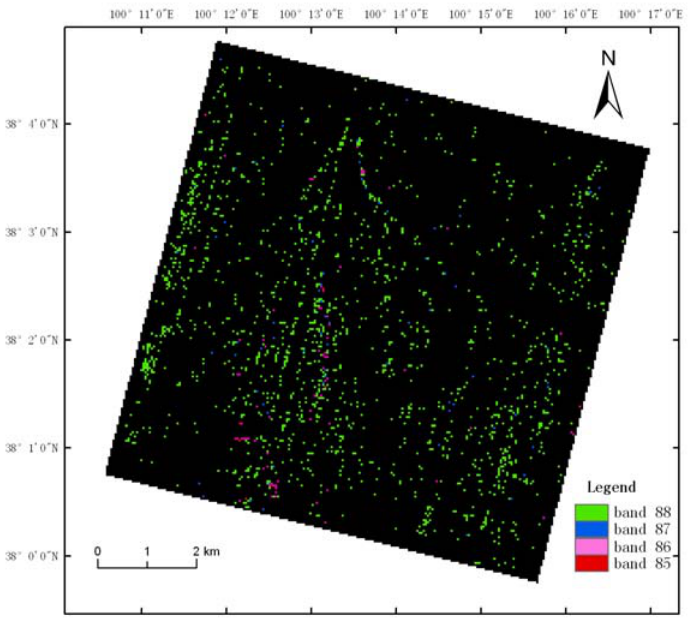
Figure 13. The distribution of the wavelength location of absorption